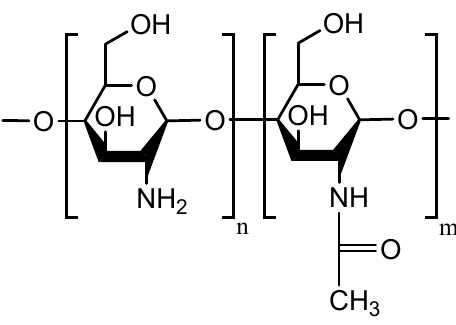
Figure 1. Chemical structure of chitosan.